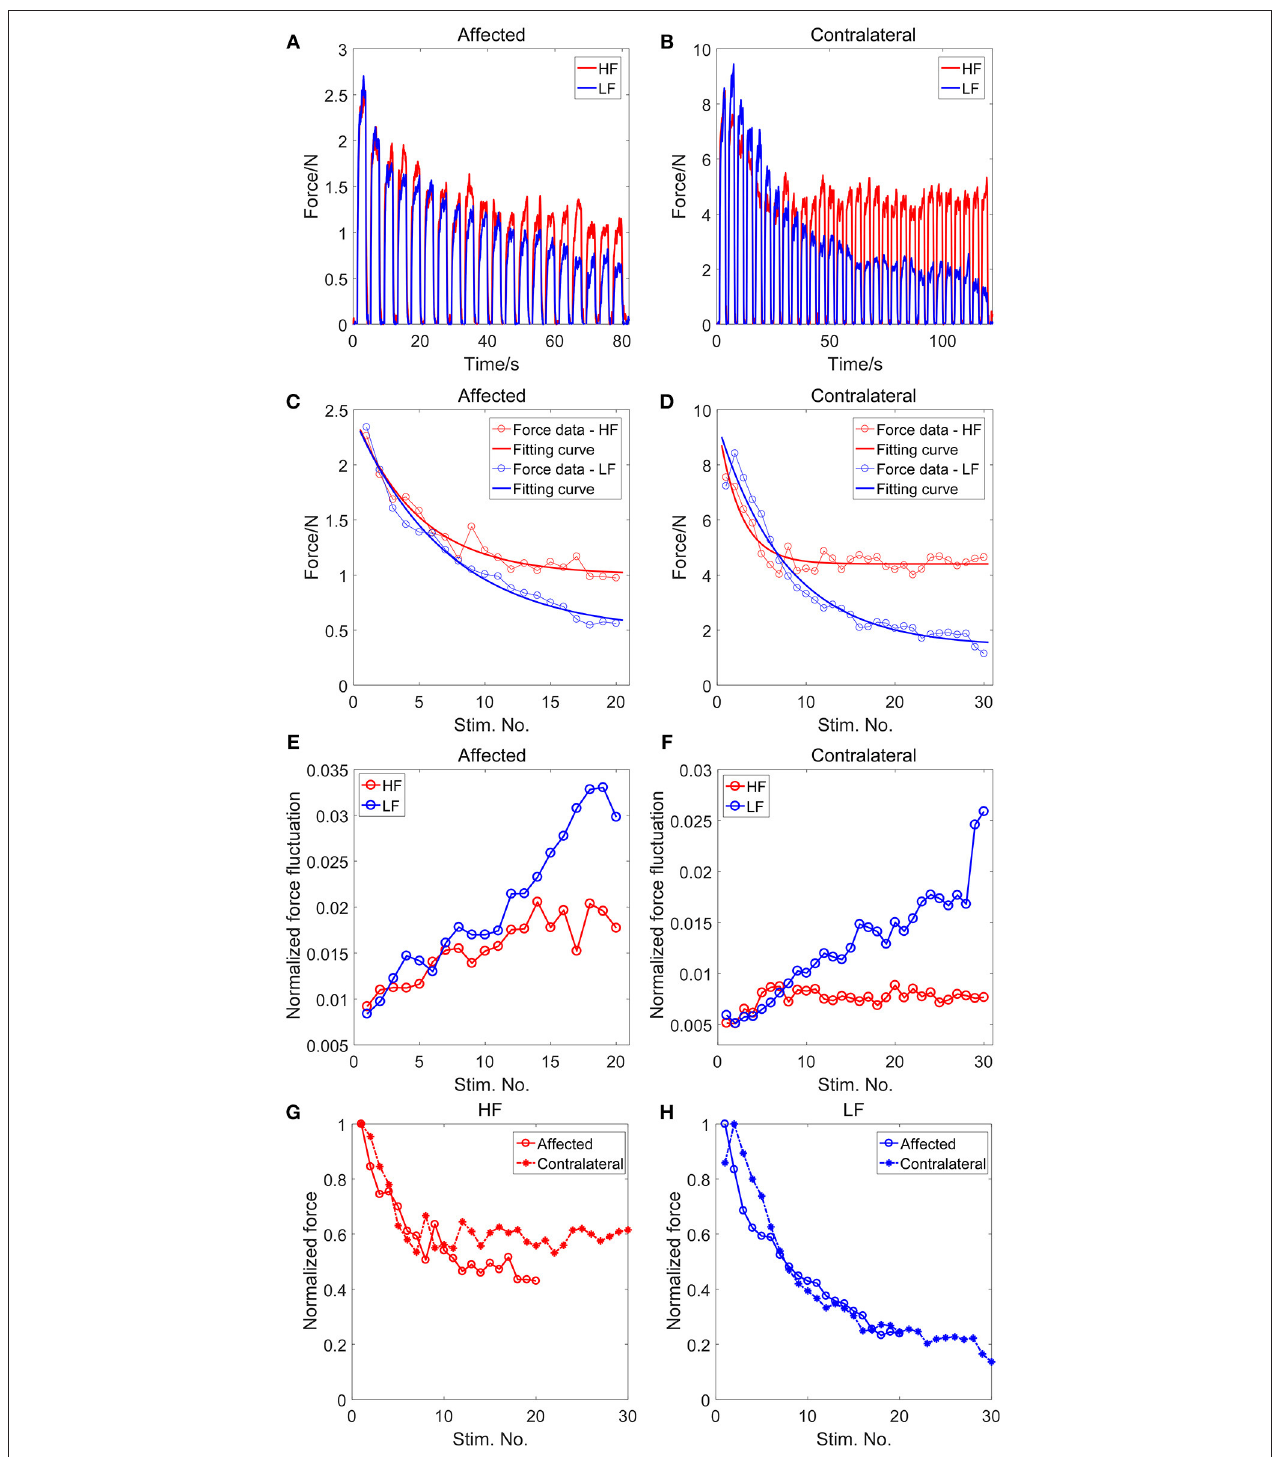
FIGURE 2 | The summated force across fingers for the affected (A) and the contralateral (B) side. The changes of the force level with the sequential stimulation trains for the affected (C) and the contralateral (D) side, and the corresponding fitting results with the exponential function. The changes of the normalized force fluctuation with the successive stimulation trains for the affected (E) and the contralateral (F) side. Comparison of the normalized force between the affected and contralateral sides under the HF stimulaion (G) and the LF stimulaion (H) .